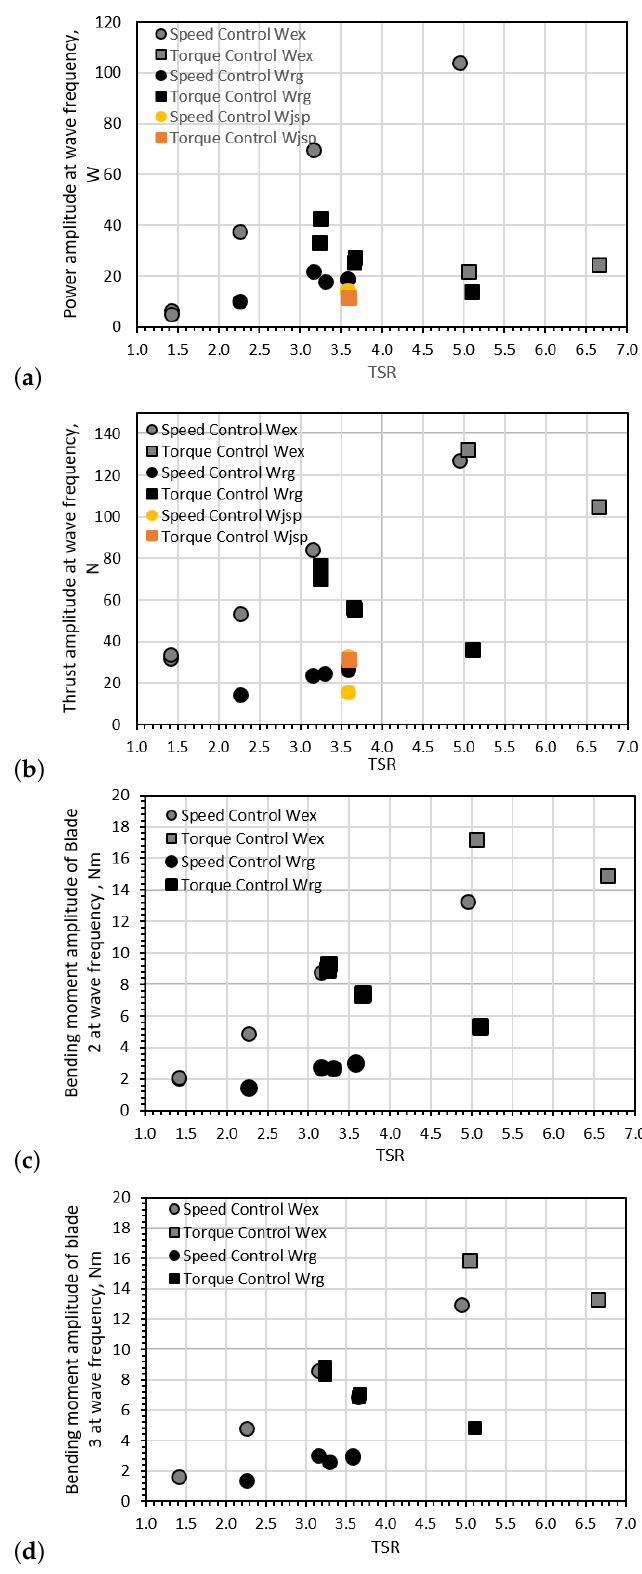
Figure 17. Amplitudes observed at wave frequencies of: ( a ) power, ( b ) rotor thrust, ( c ) root bending moment blade 2 and ( d ) root bending moment blade